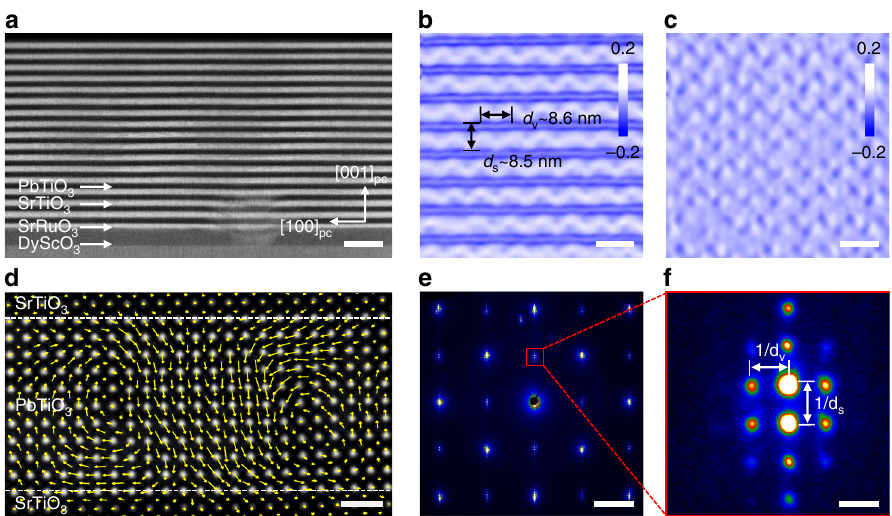
Fig. 1 Characterization of vortices in PbTiO 3 /SrTiO 3 superlattices. a Low-magni fi cation scanning transmission electron microscopy (STEM) image of a (PbTiO 3 ) 11 /(SrTiO 3 ) 11 superlattice along [010] pc , showing the alternative arrangement of SrTiO 3 and PbTiO 3 on a DyScO 3 substrate. Scale bar, 25 nm. b , c Geometric-phase analysis of the STEM data showing the distribution of the out-of-plane strain Ɛ zz and in-plane strain Ɛ xx , respectively. Scale bar, 10 nm. d Cross-sectional high-angle annular dark- fi eld (HAADF) STEM image with an overlay of the polar displacement vectors denoted by the yellow arrows showing the vortices in the PbTiO 3 layer. Scale bar, 1 nm. e A selected-area electron diffraction (SAED) pattern for the PbTiO 3 /SrTiO 3 fi lm. Scale bar, 2 nm − 1 . f Enlarged (001) spots showing the satellite diffraction spots from the ordered vortex. The vortex and superlattice periods are measured to be 8.6 and 8.5 nm, respectively, denoted by d v and d s . Scale bar, 0.1 nm − 1 .